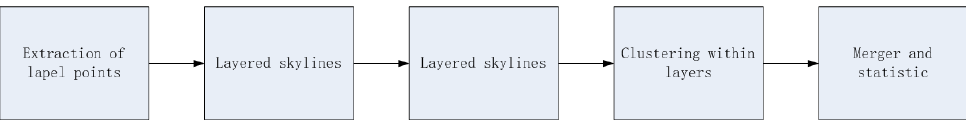
Figure 11. The flow chart of clustering lapel points.